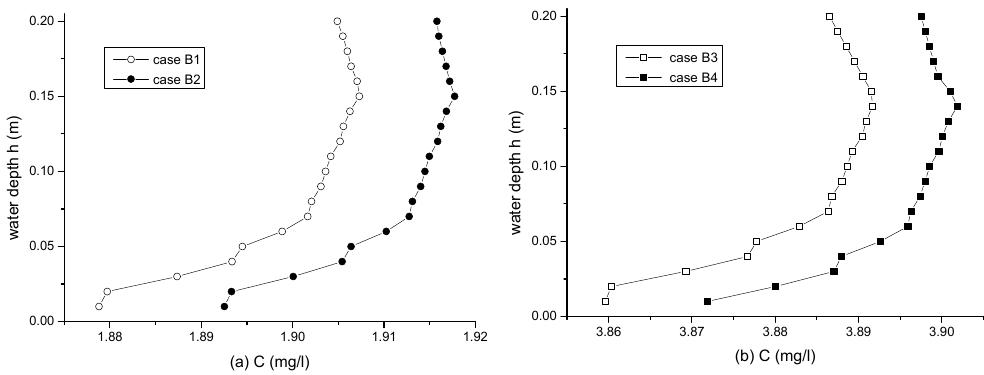
Figure 8. Variation of the concentration of dissolved P in the water of case B1–B4 at an equilibrium state.